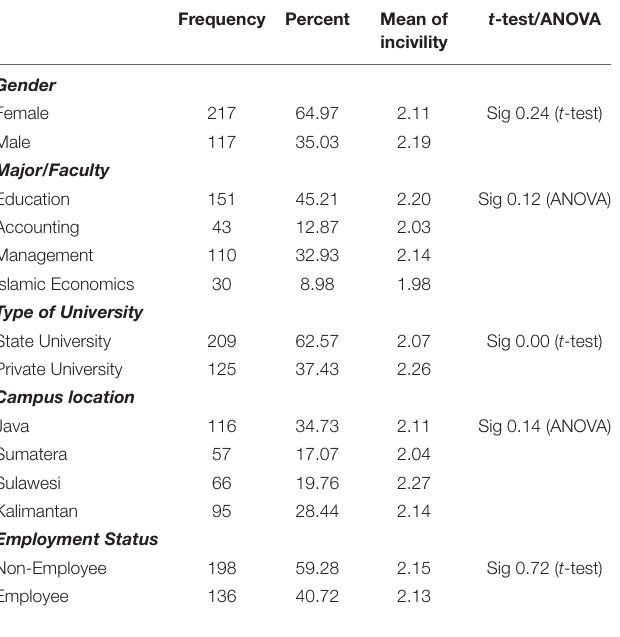
TABLE 1 | Respondent characteristics.